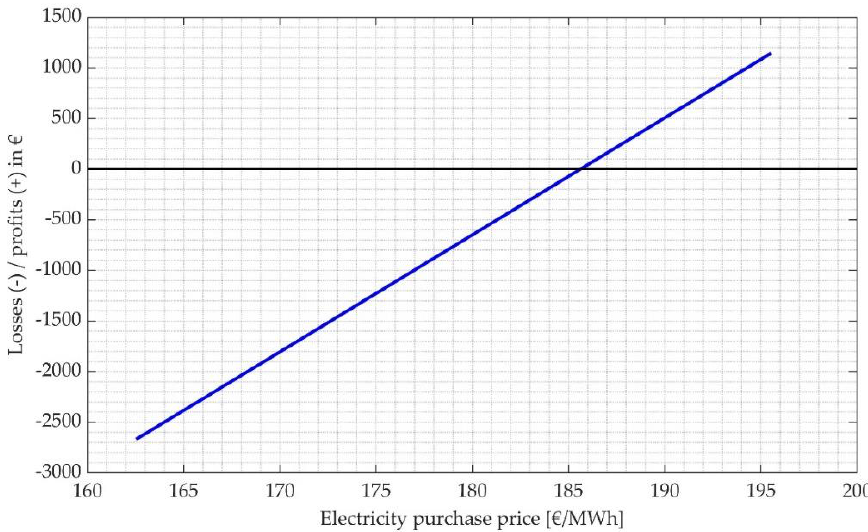
Figure 14. Values of losses and profits depending on energy purchase price.